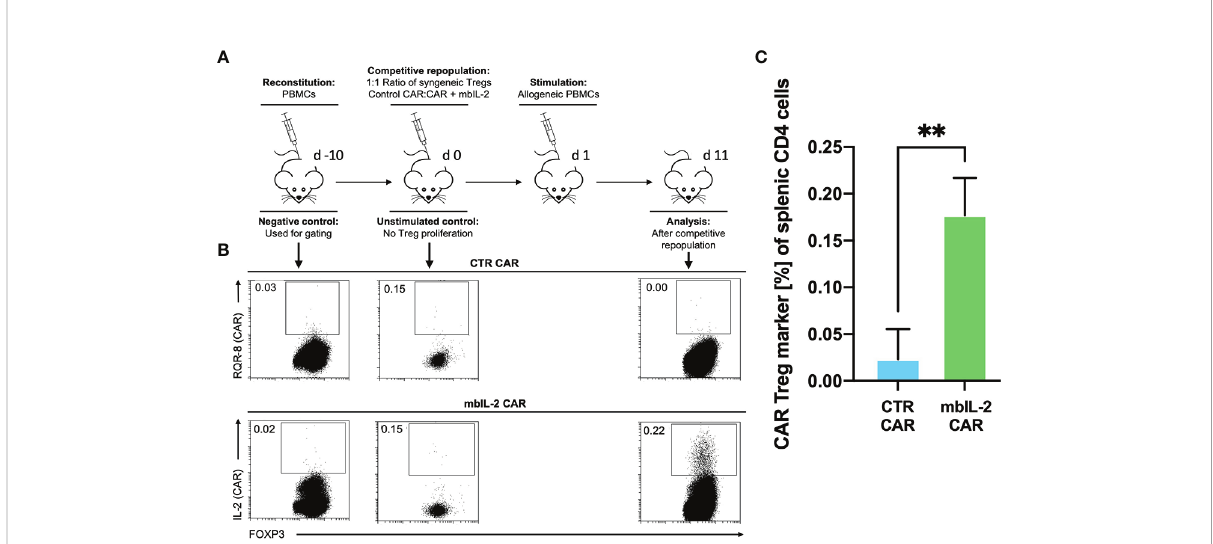
FIGURE 8 mbIL-2 enhanced CAR-Treg survival in an IL-2-limiting environment in a preclinical humanized mouse model. (A) Experimental setup. On Day -21, NRG mice were reconstituted with HLA-A*02negative PBMCs. Differently labelled syngeneic mbIL-2 CAR and CTR CAR-Tregs were adoptively transferred at day 0 in a 1:1 ratio followed by a single injection of allogeneic human HLA-A*02+ PBMCs to ensure a CAR-speci fi c allogeneic stimulus. Spleens were isolated and analysed on day 10. (B) Representative dot plots show the decreasing fraction of CTR CAR-Tregs in the spleens of animals compared with that of mbIL-2 CAR-Tregs in this limiting IL-2 environment. (C) Bars summarize the data from all experiments. While a tenfold increase in mbIL-2 CAR-Tregs (0.18% +/-0.04%) could be observed, the number of CTR CAR-Tregs fell below the threshold value (0.02% +/- 0.03%). n=3 different mice. Signi fi cance was calculated using an unpaired t test. Error bars show the mean ± SD. P value ** ⪬